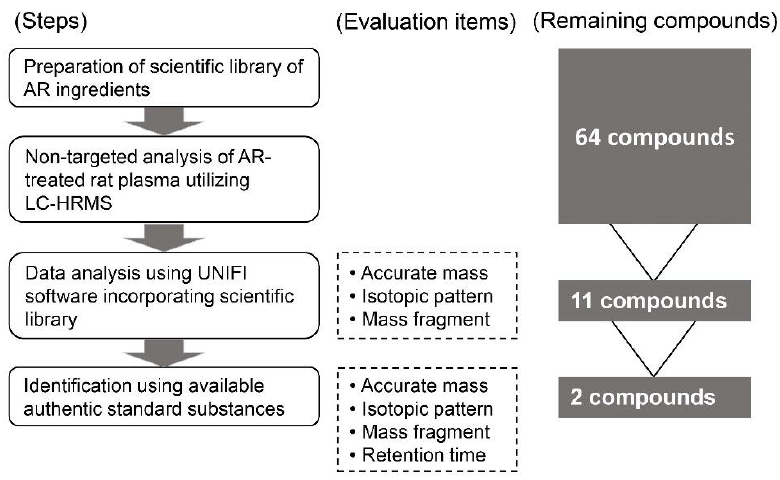
Figure 1. Procedures for liquid chromatography-high-resolution mass spectrometry (LC-HRMS) (non-targeted) analysis.